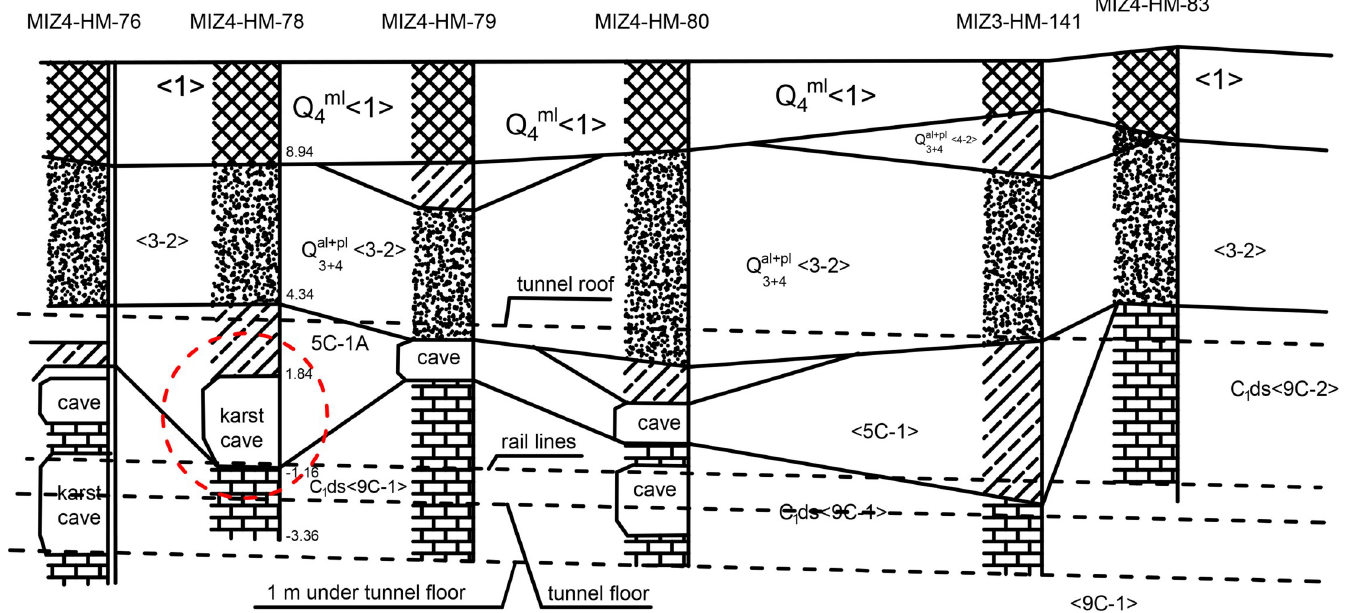
Fig 4. Geological details of the karst region in which the tunnel was